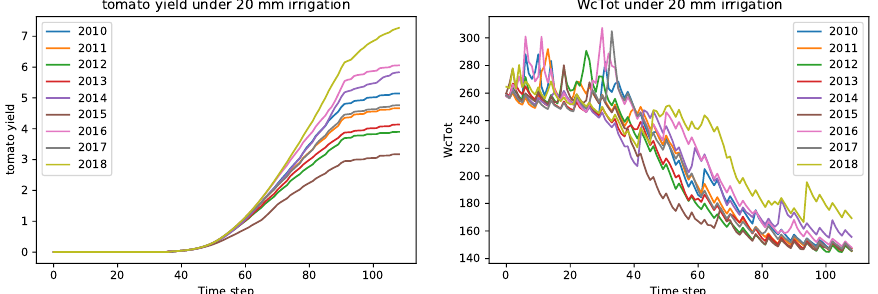
Figure 7. Evolution of tomato yield and total water content profile under fixed irrigation depth of 20 mm. Left side shows tomato yield and right side shows WCTot.